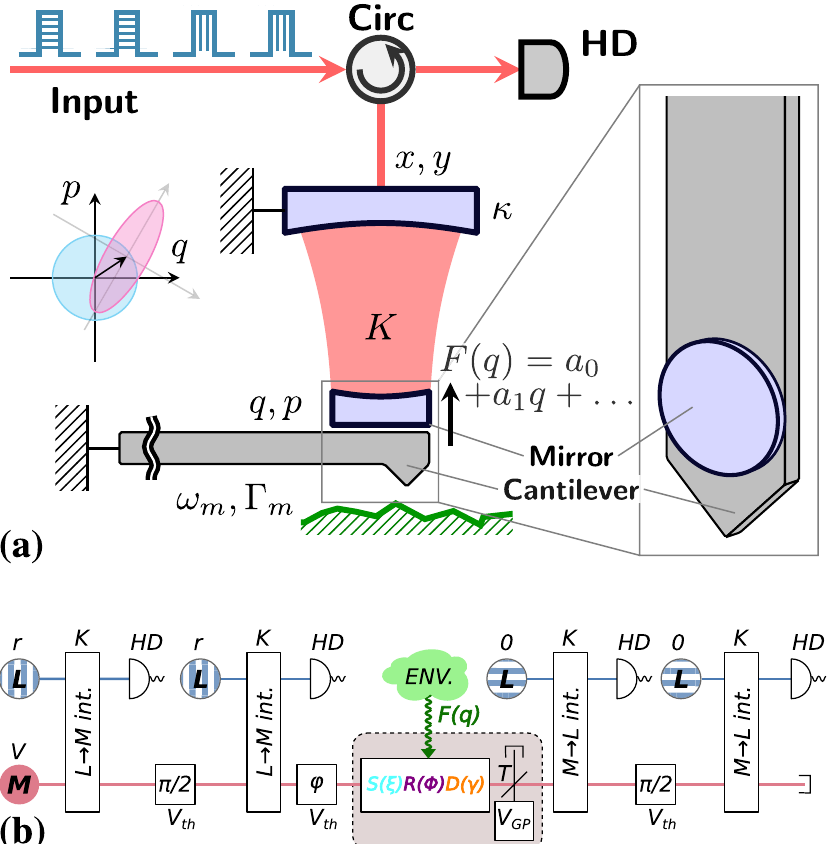
Figure 1. ( a ) Experimental proposal of our pulsed optomechanical scheme for the fast sensing of a small linearized mechanical force. The passive optical circulator (Circ) directs the pulses of light to the optomechanical cavity to interact with the mechanical oscillator probing the force (here: a mirror mounted on a cantilever), and then to an optical low-noise homodyne detector (HD). The deterministic part of a linearized small mechanical force described by the Gaussian unitary transformation in Eq. (1) can be provided by the interaction of the cantilever with a surface (shown in green). The inset in the frame shows an example of the physical implementation of a mirror mounted on the tip of a cantilever (inspired by Ref. 61 ). ( b ) Schematic representation. A mechanical oscillator (mode M ) in thermal state with variance V interacts four times with a coherent light mode (mode L ) with amplitude r (for encoding, vertical stripes) or vacuum (for read-out, horizontal stripes), respectively; their interaction is approximated by a QND interaction (9) of strength K . Between the encoding and the readout, the matter mode can be modified by a general Gaussian process ( GP ) including loss ( T ) and noise ( V GP ). The squares mark free evolution of the mechanical mode either for making the QND couplings in orthogonal directions (marked with π/ 2 ) or in preparation for having different input states of the Gaussian process (marked with ϕ ). During these free evolutions there is also some thermalization present ( V th ). The quadratures of the light are measured using HD to estimate the parameters of the Gaussian process. The mode M itself is inaccessible other than by an optomechanical